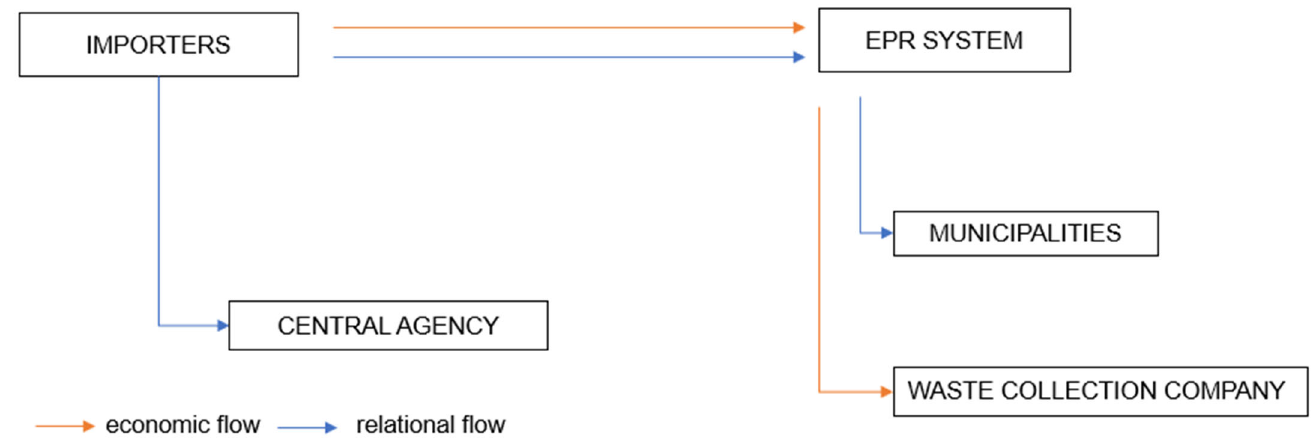
Figure 1. German packaging waste management model. Source: own elaboration based on [22,23].